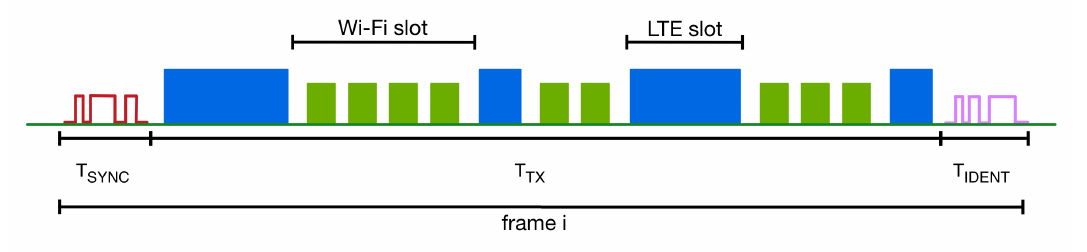
Figure 8. Enhanced CSAT time